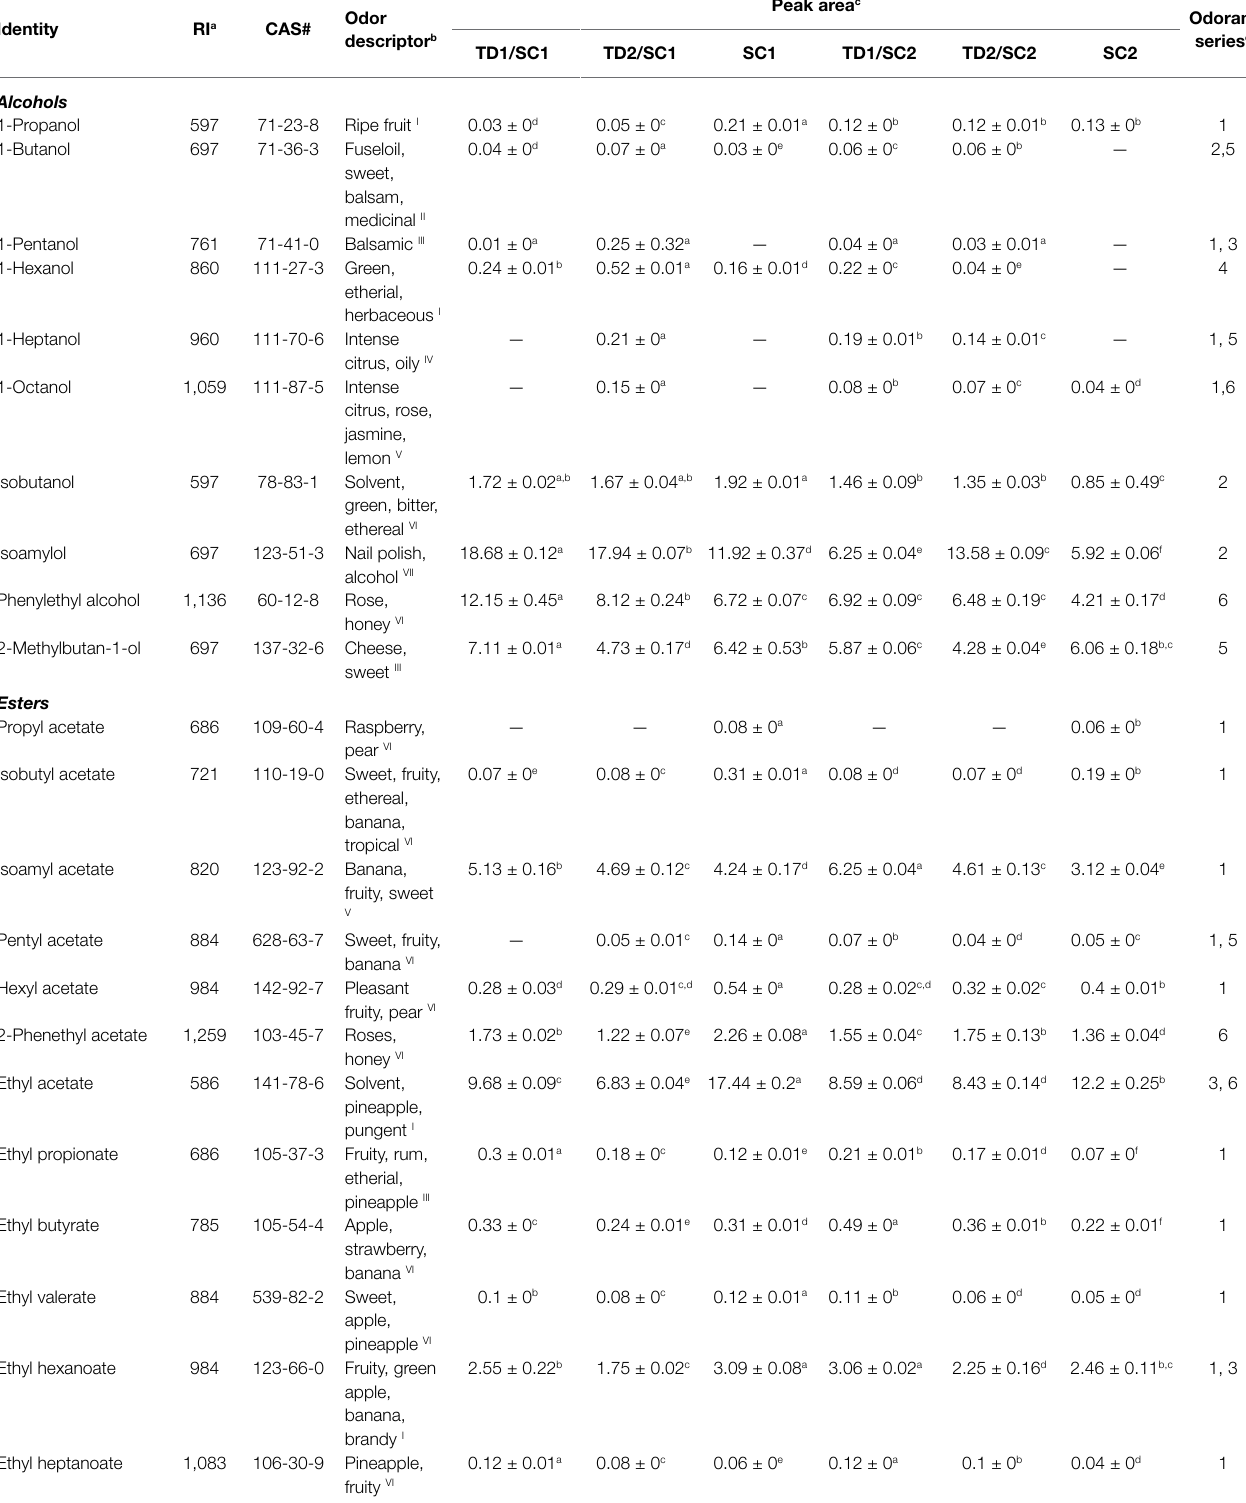
TABLE 2 | Major aroma compounds (mean GC-FID peak area × 10 6 ) in mixed and pure culture fermented icewines.